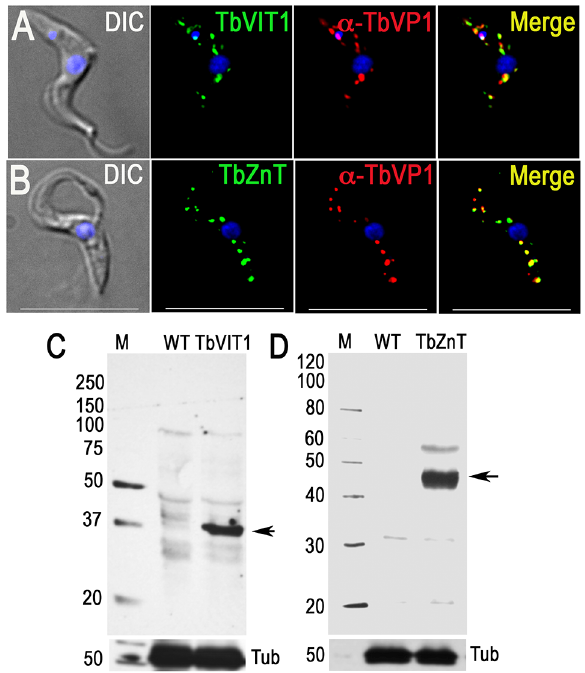
Fig. 5. Immunofluorescence microscopy and western blot analyses of metal ion transporters. Epitope-tagged TbVIT1 (A) and TbZnT (B) and co-localize with TbVP1 to the acidocalcisomes (Pearson’s correlation coefficients of 0.6879 and 0.7604, respectively). Yellow in merge images indicate co-localization. Scale bars for A– B=10 m m. Tagging with HA was confirmed by western blot analyses of TbVIT1 (C) and TbZnT (D) using anti-HA antibodies. Markers are at the left side, and arrows show the corresponding bands. Tubulin ( Tub ) was used as a loading control ( bottom panel ).